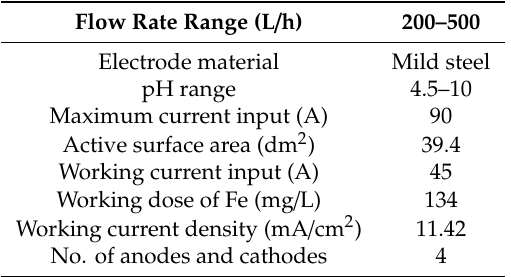
Table 3. Technical data of the electrocoagulation (EC)